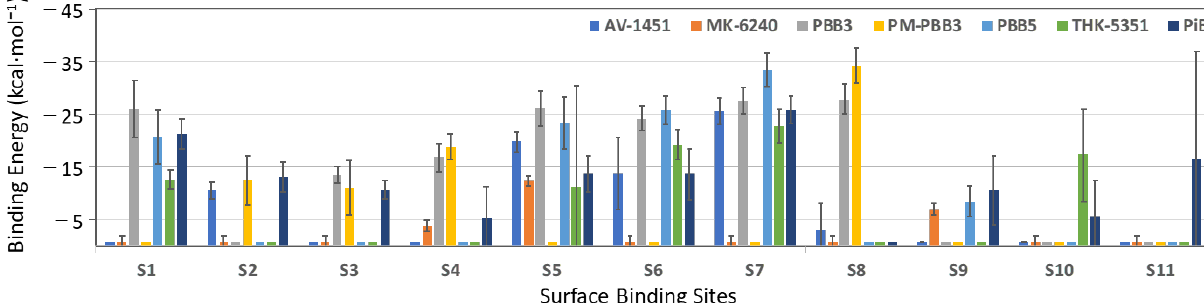
Figure 2. Graph of MM/GBSA binding energies of PET probes in surface binding site (S1 to S11). MM/GBSA binding calculations on 1000 frames suggest that Pick’s tau core has mul-